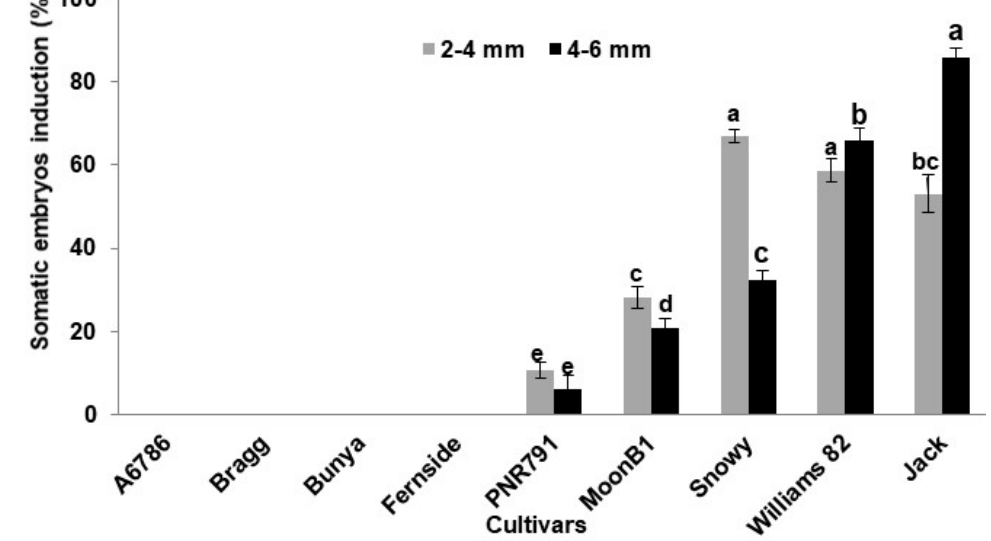
Figure 3. Comparison of somatic embryos induction of soybean cultivars from two different sizes of immature cotyledon explants. Data points represent the mean ± SE of three replicates. Column values with different letters are statistically significant at p < 0.05.